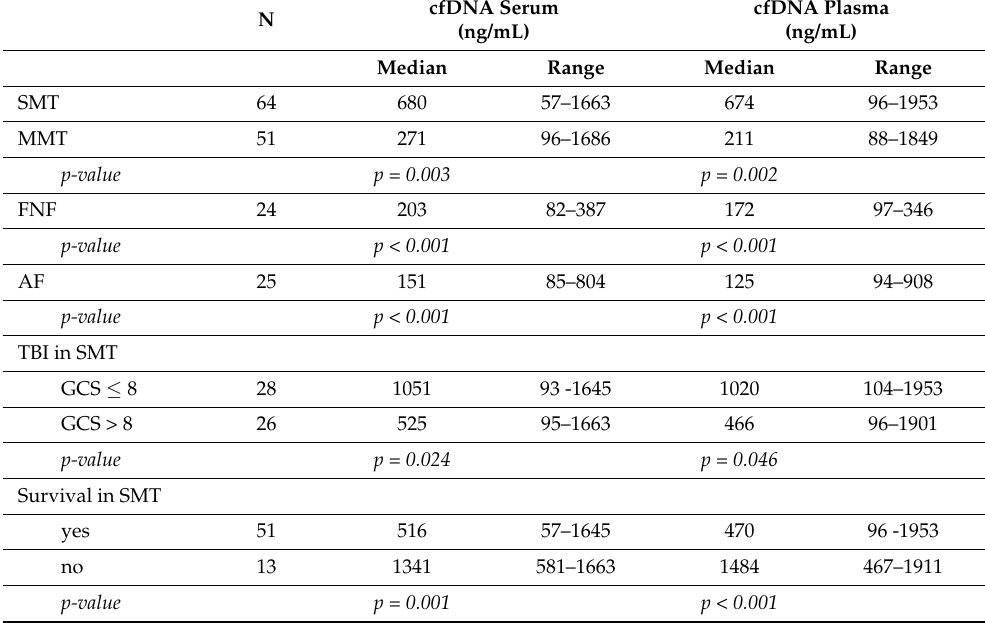
Table 2. cfDNA concentrations in serum and plasma in various disease groups. In patients with severe polytrauma, differences in cfDNA concentrations in severe versus moderate TBI and in first week survival and non-survival are shown.